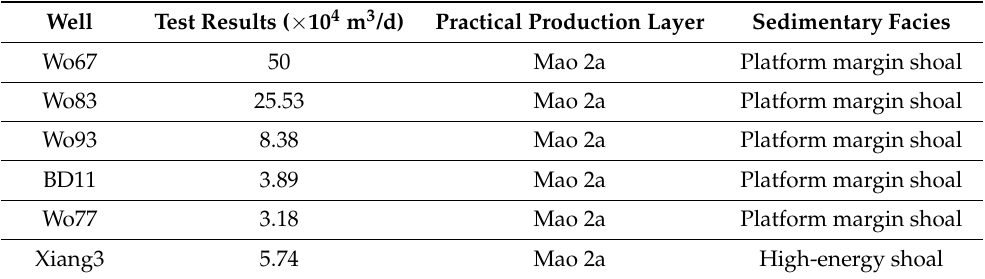
Table 2. Corresponding relationship between gas test results and sedimentary facies. Well Test Results ( × 10 4 m 3 /d) Practical Production Layer Sedimentary Facies Wo67 50 Mao 2a Platform margin